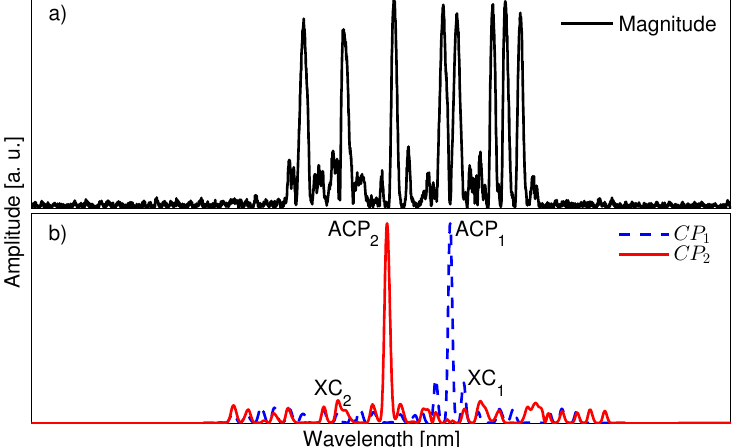
Figure 4. ( a ) Total reflected frequency response of the sensing network composed of two encoded fiber Bragg grating (FBG) sensors; and ( b ) the correlation product CP k computed for each sensor. The corresponding auto-correlation peak (ACP) value points to the matching wavelength location of each sensor in the spectrum. Cross correlation values (XC) are obtained for the remaining wavelength